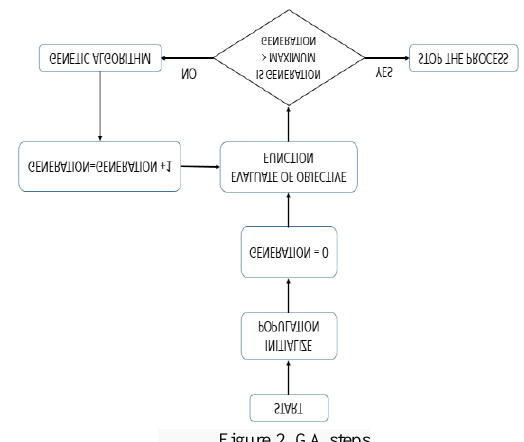
Figure 1. Maximum-margin hyper plane and margins for an SVM trained with samples from two classes (Samples on the margin are called the support